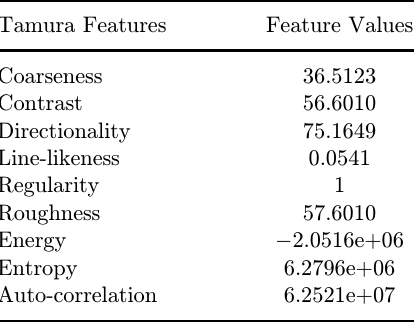
Table 1. The results of tamura